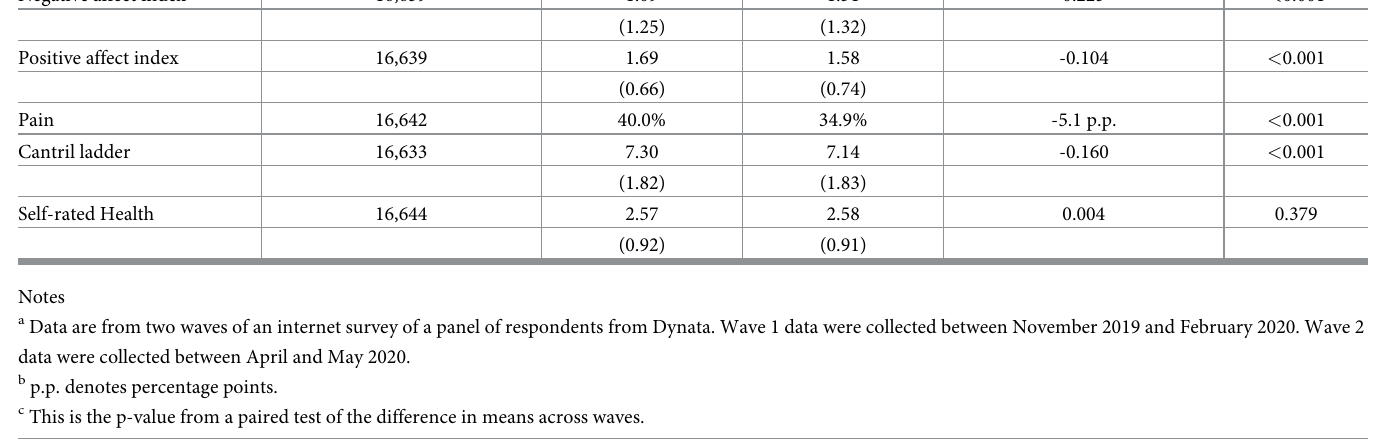
marriage status and income: the ladder declined by 0.209 (95% CI: -0.247 to -0.170) scale points or about about 0.12 of the standard deviation of 1.6 for married respondents but only 0.072 (95% CI: -0.132 to -0.012) or 0.04 of the standard deviation of 1.7 for unmarried respon- dents. While we found no change in the Cantril ladder for those with income below $50,000 at